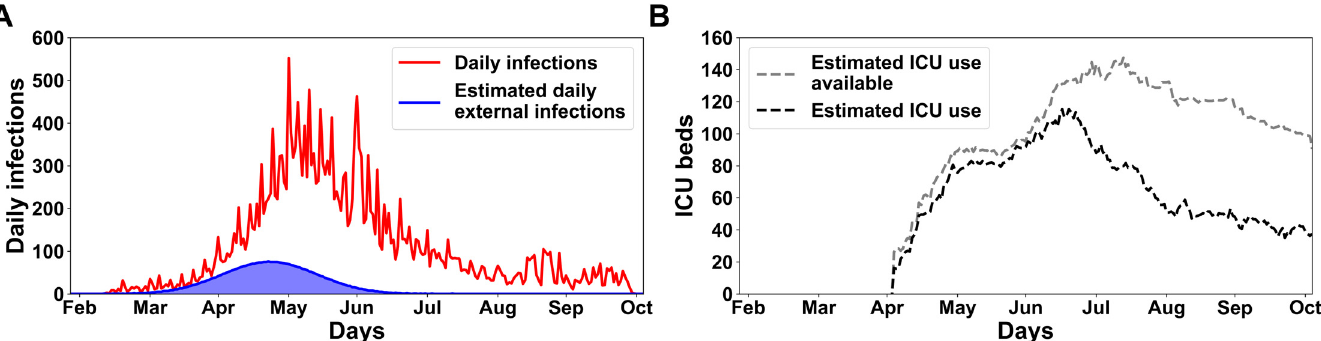
Fig 3. Epidemiological data on the first wave of the Covid-19 pandemic in the City of Natal, Brazil. (A) The daily number of confirmed cases with a total of 26,371 cases and a peak of 552 new cases in one day (red line), and the estimated daily number of external cases with a total of 3,957 cases with a peak of 76 new cases (blue line and area). (B) Estimated ICU beds available (silver dashed line) and utilized (black dashed line) during the first wave. Numbers for Natal are estimated as 46.68% of the metropolitan region